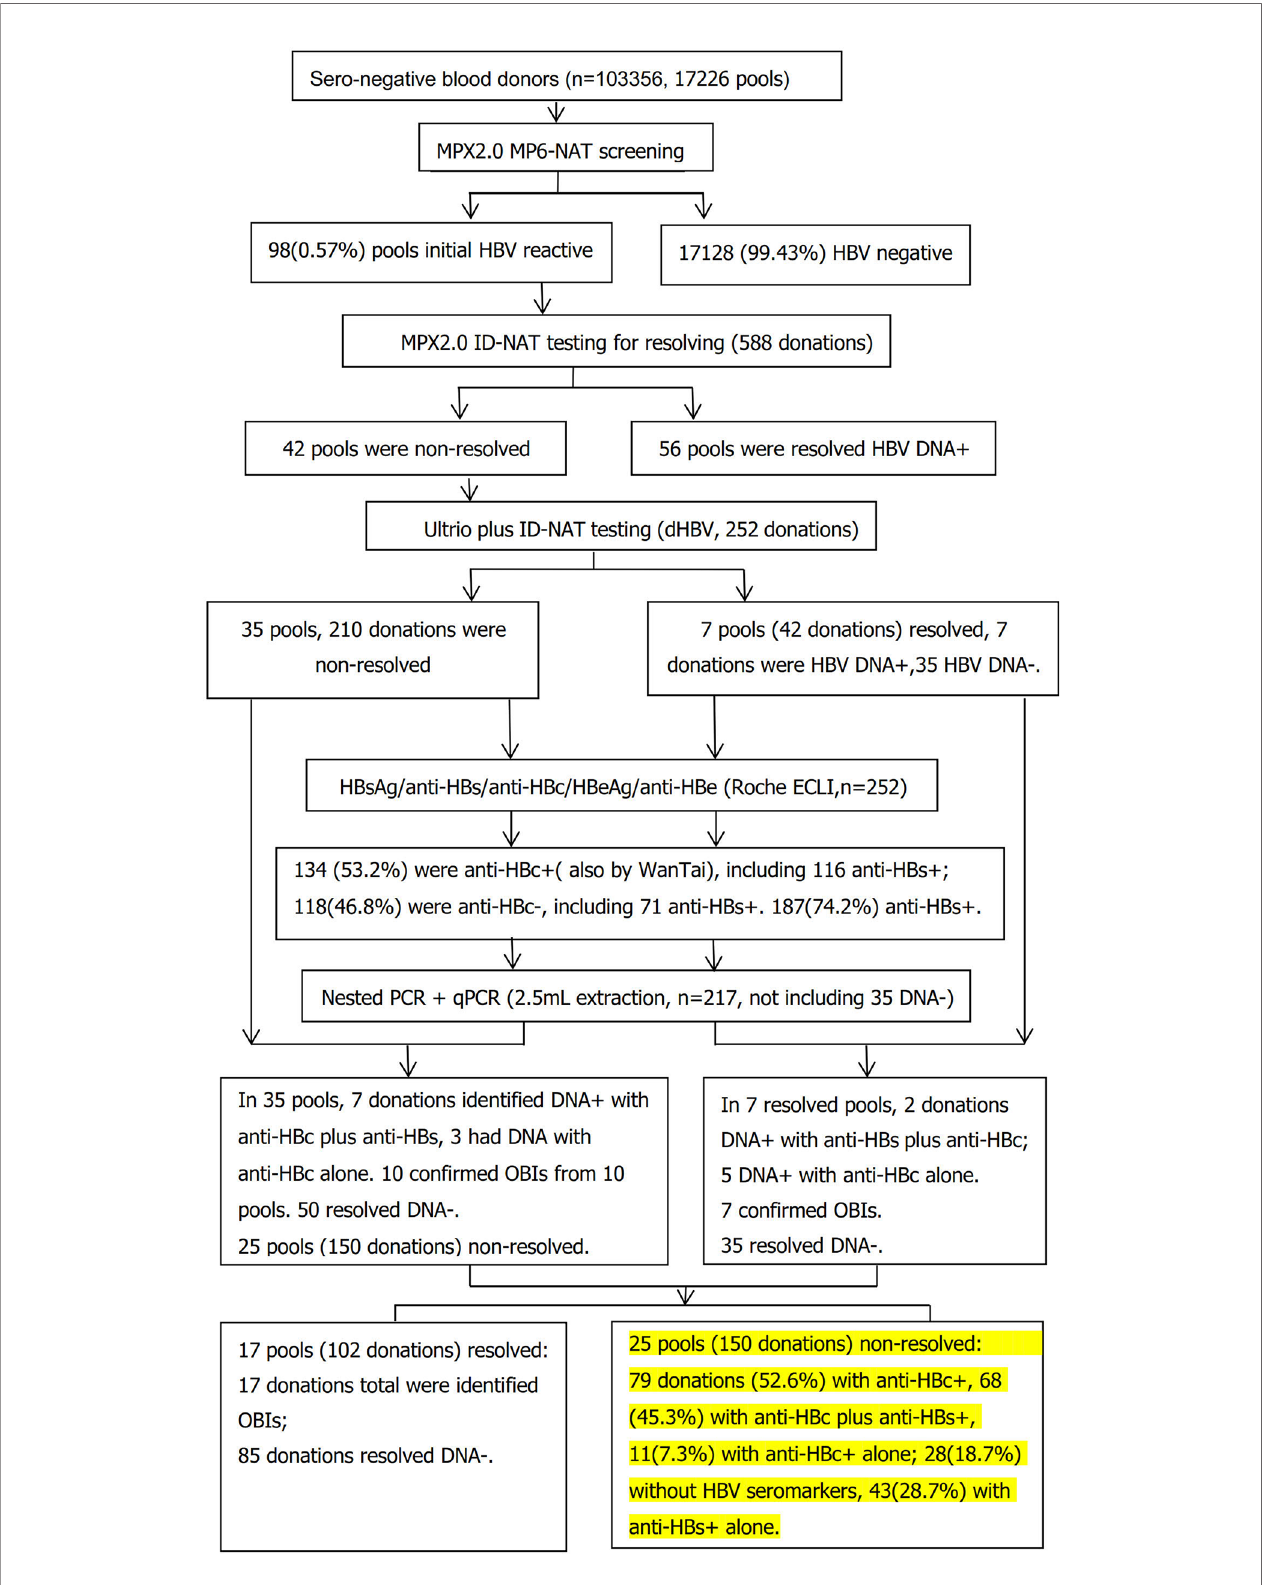
FIGURE 1 | Flow chart of serological and molecular identi fi cation of MPX 2.0 MP6-NAT in non-resolved